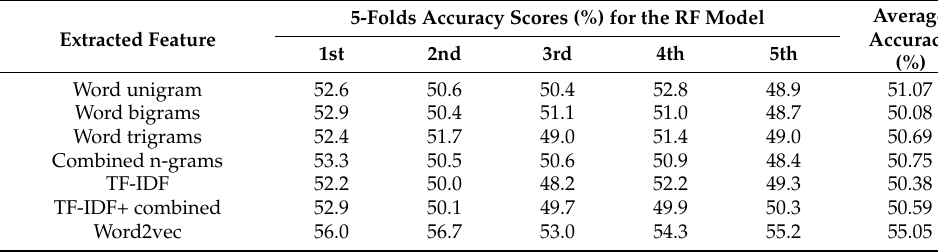
Table 13. RF models’ accuracy scores on each features using three class dataset. Extracted Feature